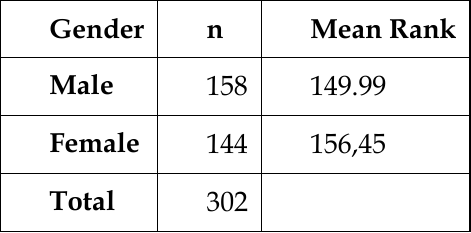
Figure 10. Trust towards the health centre and gender. Percentage per reported value on scale 5-1. Male n=158 (100%); Female n=144 (100%). Total n=302.